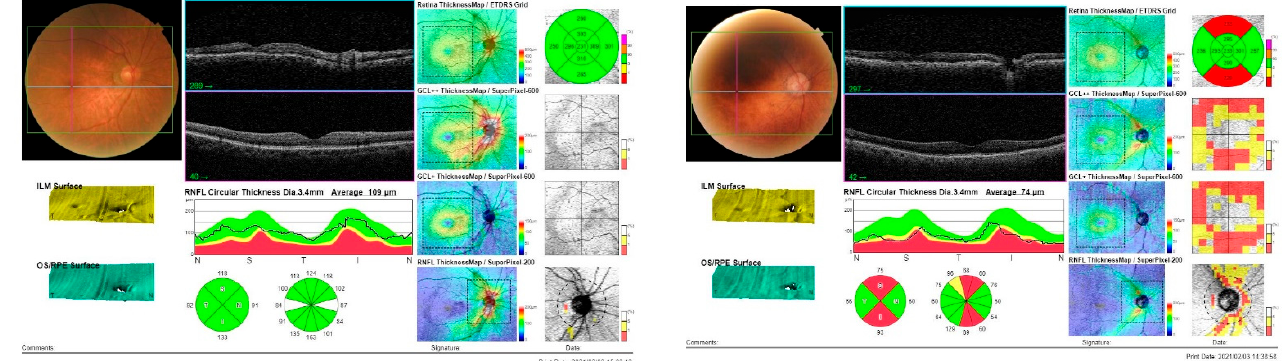
Figure 1. OCT measurement: examples of one ACE-normal case ( left ) and an ACE-abnormal case ( right ).